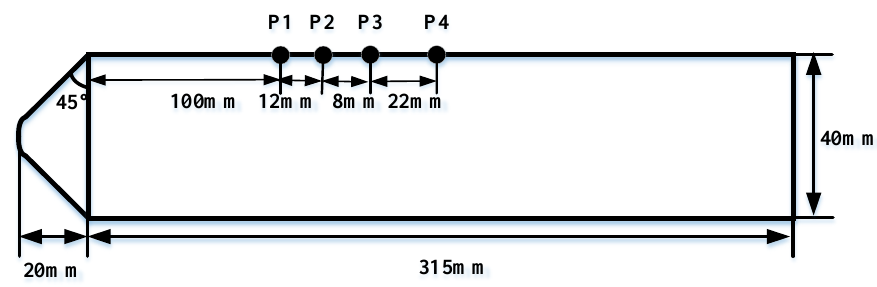
Figure 1. Experimental setup and computational geometric model.